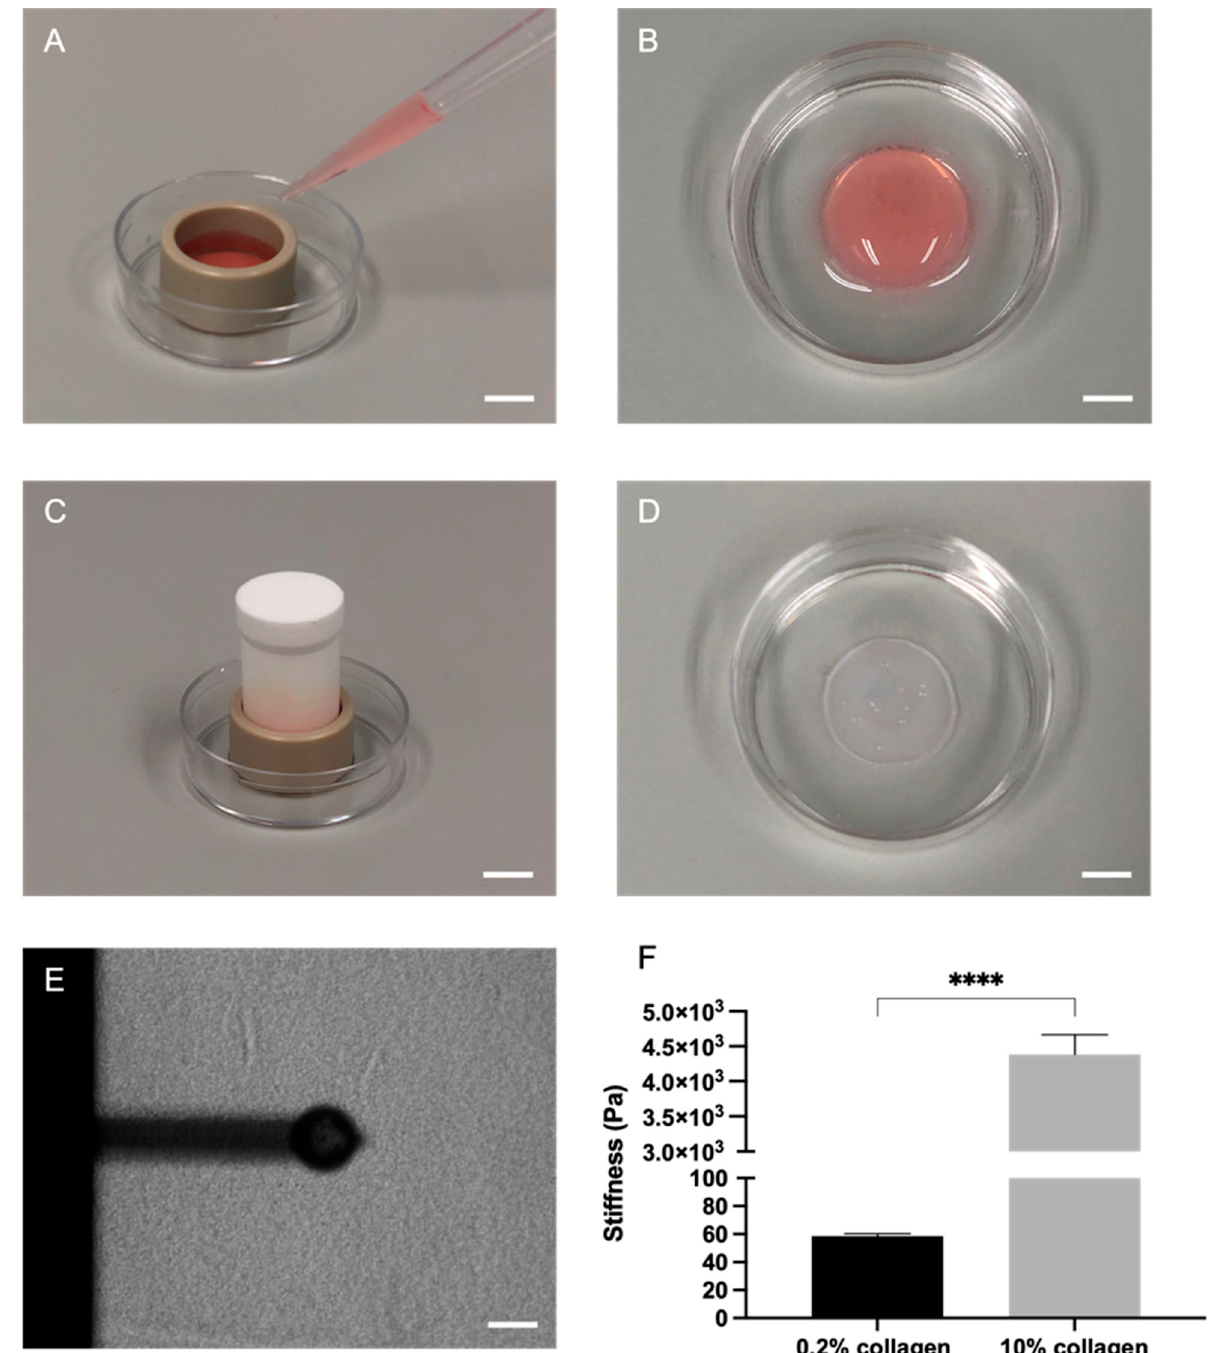
Figure 2. Atomic force microscopy (AFM) of collagen gels with varying collagen concentrations. ( A ) Casting of collagen gels within a polyetheretherketone (PEEK) ring. ( B ) Soft hydrogel (0.2% collagen) within petri dish. ( C ) Plastic compression with RAFT TM absorbers. ( D ) Stiff plastic-compressed gel (10% collagen) within petri dish. Scale bar = 10 mm for ( A,C ) and 5 mm for ( B , D ). ( E ) Positioning of cantilever with glass bead. Scale bar = 50 µm. ( F ) Stiffness (Young’s modulus ( E ), Pa) of acellular 0.2% collagen and 10% collagen gels as measured through AFM. Mann-Whitney significance is shown. All p -value significance is indicated as: **** p < 0.00005. 2.2. The Inherent EMT Status of HT-29 Cells and MDA-MB-231 Epithelial Cancer Cells HT-29 cells are epithelial cancer cells that have yet to undergo EMT. The epithelial cancer cells MDA-MB-231, however, inherently present strong mesenchymal-like fea- tures, suggesting they have already undergone EMT at the time of the cell harvest and